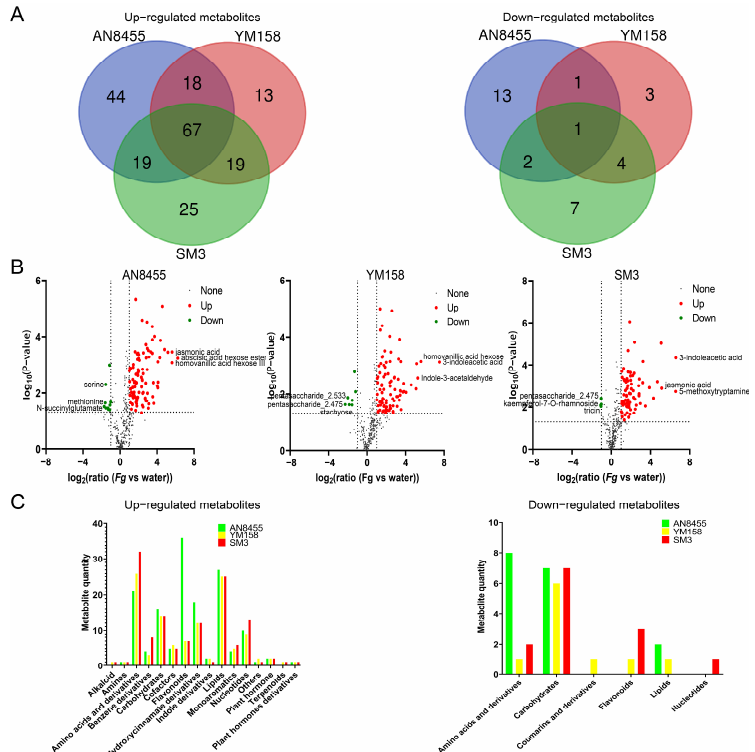
Figure 2. Analysis of metabolomic data. ( A ) Venn diagram of upregulated and downregulated metabolites in the three varieties: AN8455, YM158, and SM3. ( B ) The volcano plots of metabolites. Metabolites that are upregulated and downregulated by more than two times are marked. The upregulated metabolites are marked in red, and the downregulated metabolites are marked in green. ( C ) Column statistical chart of the types and quantities of upregulated and downregulated metabolites in the three varieties. Table 1. List of significantly changed metabolites in all three varieties post Fg inoculation.